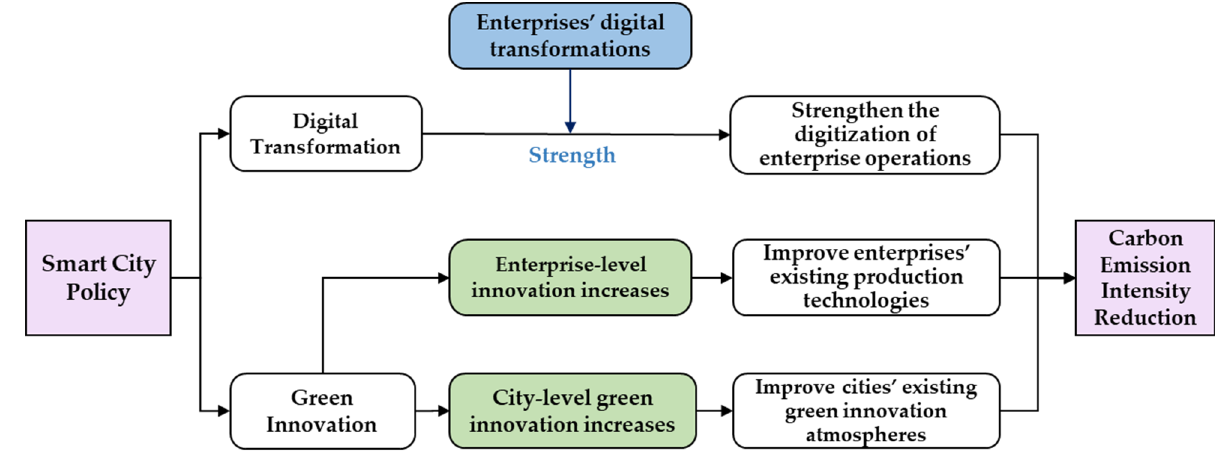
Figure 5. The mechanism analysis of the effect of SCP on carbon emission intensity.